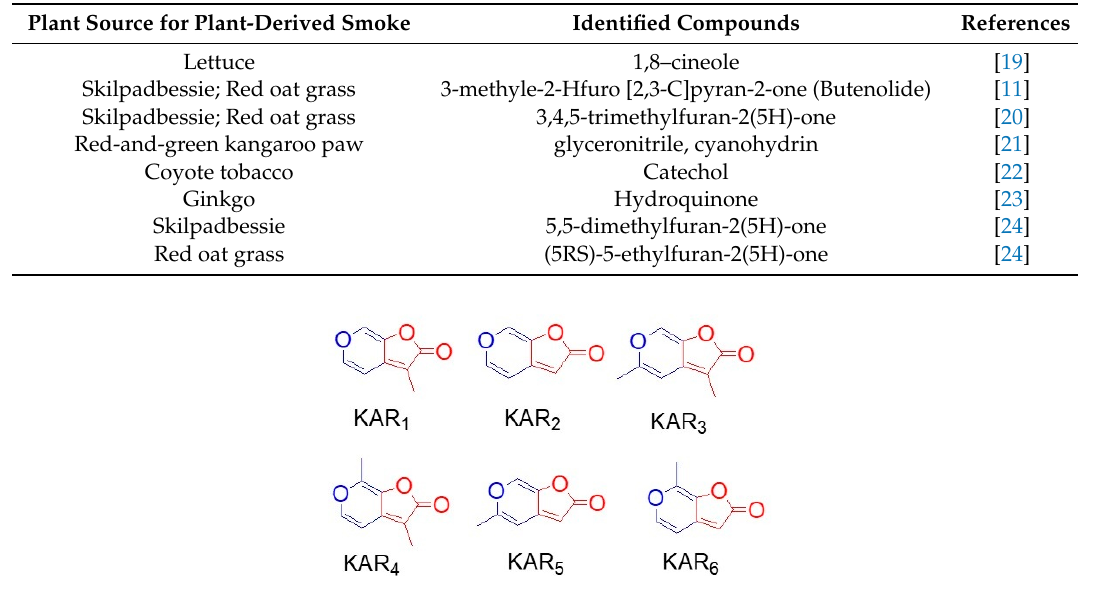
Figure 2. Chemical structures of karrikins family involved in seed germination. KAR1, KAR2, KAR3, KAR4, KAR5, and KAR6 were shown. All karrikins share the basic structure commonly with two ring structures: one is a six-membered heterocyclic pyran shown as blue and the other is a five-membered lactone ring as a butanolide shown as red. Table 1. A list of different compounds identified in plant-derived smoke.